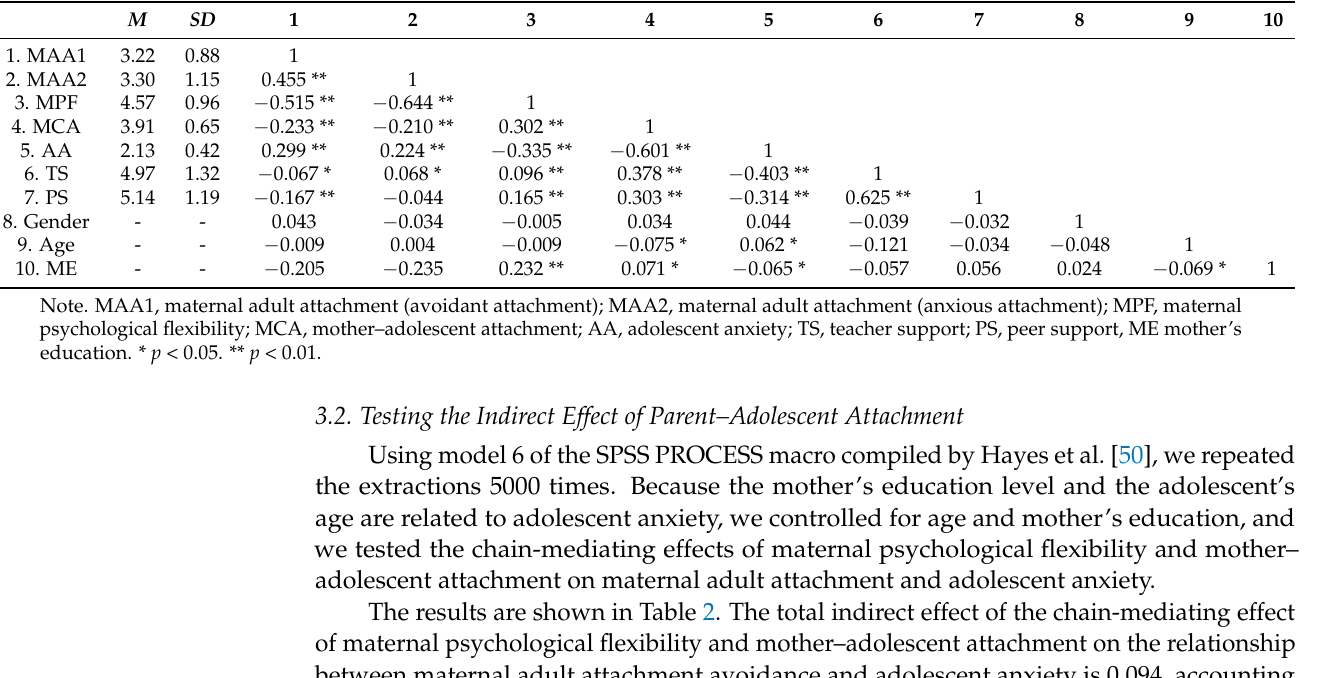
Table 1. Pearson correlations and descriptive statistics of the main study variables (N = 1139).